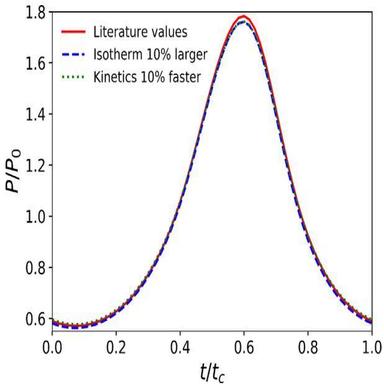
Pressure profiles of the CO2 simulation runs in the packed bed with different isotherm and kinetic parameters. Conditions: T0 = 30 C; u = 0.5p; Stroke1 = Stroke2 = 0–100 mm, tc = 4 s.